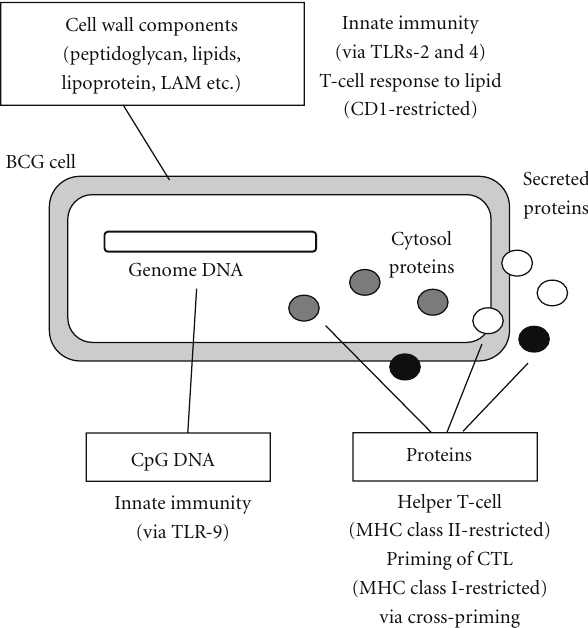
Figure 1: Outline of immune responses by BCG. Both innate immunity via TLRs and antigen-specific immunity via MHC- or CD1-restricted antigen presentation to T cells are induced by various BCG cell